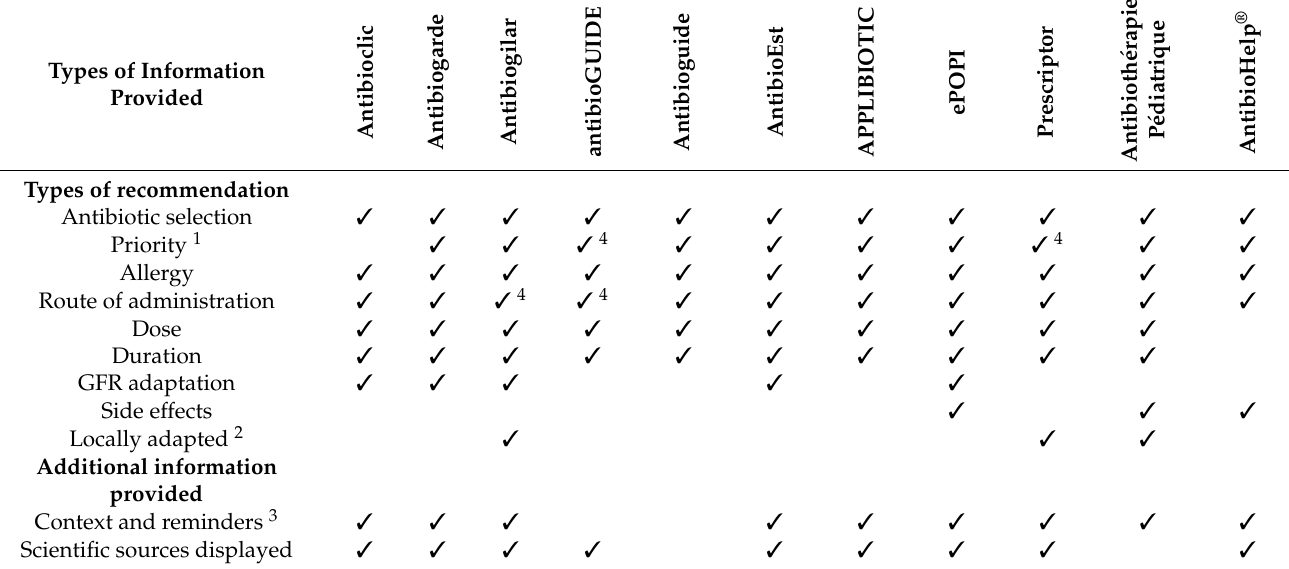
Table 3. Individual characteristics of the CDSSs regarding the types of information